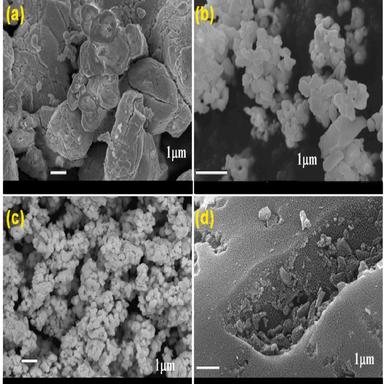
The FE-SEM images of the synthesized (a) undoped Ta3N5, (b) V doped Ta3N5, (c) V@S codoped-Ta3N5, and (d) V@S-Ta3N5/PANI composite.